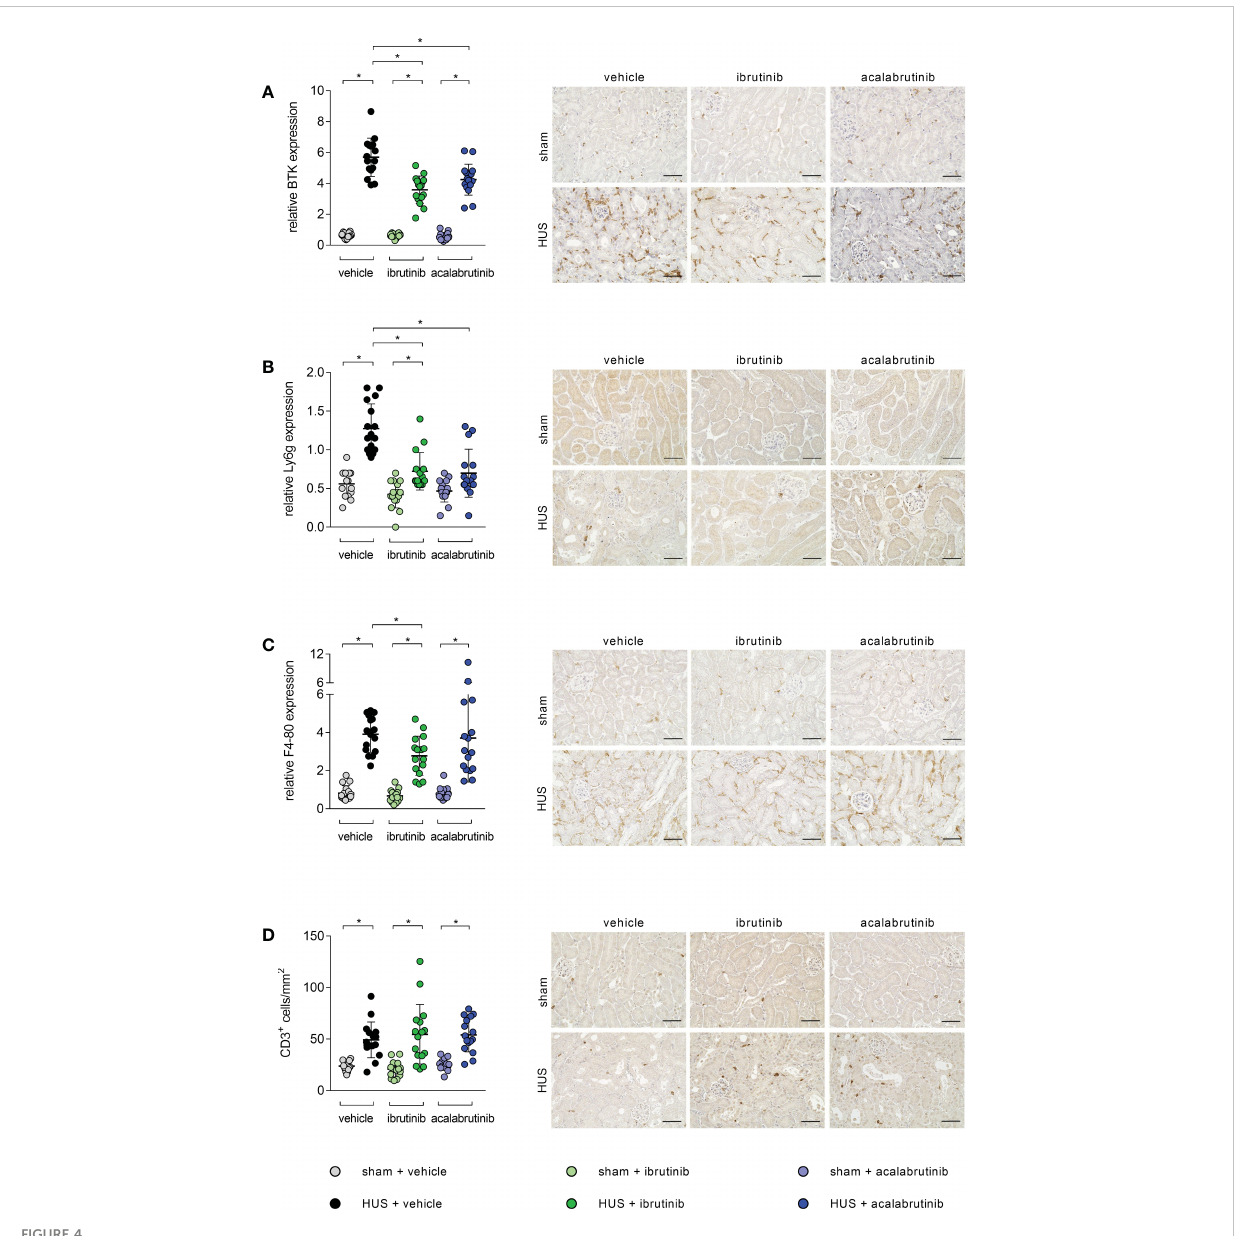
FIGURE 4 Renal immune response of mice with HUS treated with ibrutinib or acalabrutinib. Quanti fi cation and representative images of (A) BTK, (B) Ly6g, (C) F4-80 and (D) CD3 expression in renal sections (n = 16 per group) on humane endpoint or day 7. Bars = 50 µm (400x magni fi cation). Data are expressed as scatter dot plot with mean + SD. (A, C, D) ordinary one-way ANOVA + Holm-Sidak ’ s multiple comparison test. (B) Kruskal-Wallis test + Dunn ’ s multiple comparison test. *P < 0.05. BTK, Bruton ’ s tyrosine kinase; Ly6g, lymphocyte antigen 6 complex, locus G; HUS, hemolytic-uremic